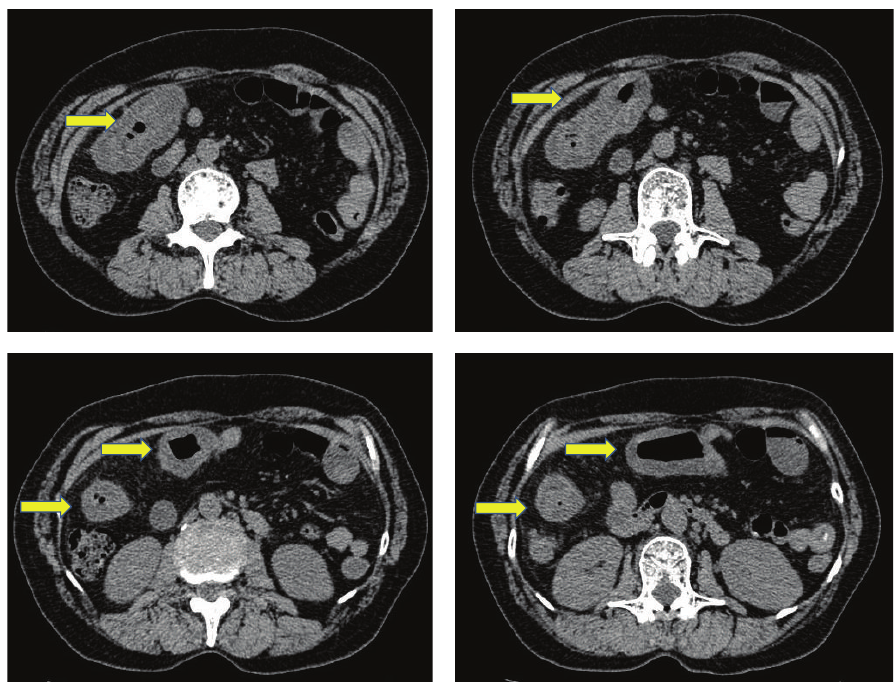
Figure 1: Abdominal computed tomography test revealed the slight edema of the ascending to transverse colon.